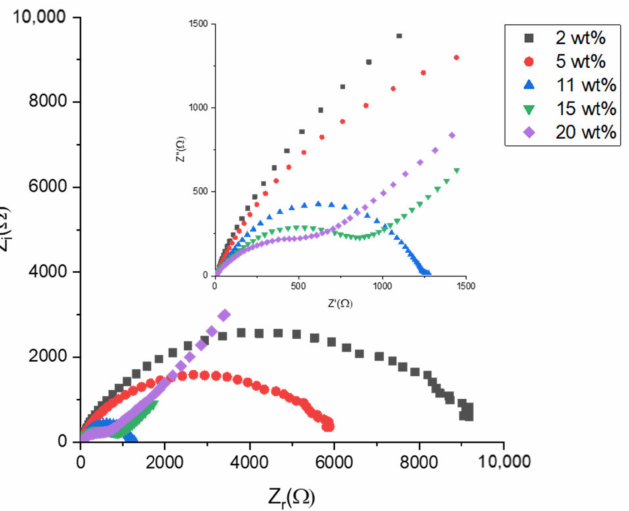
Figure 3. Impedance plot for CH/Na polymer matrix with different weight percentages of CuSe filler measured at room